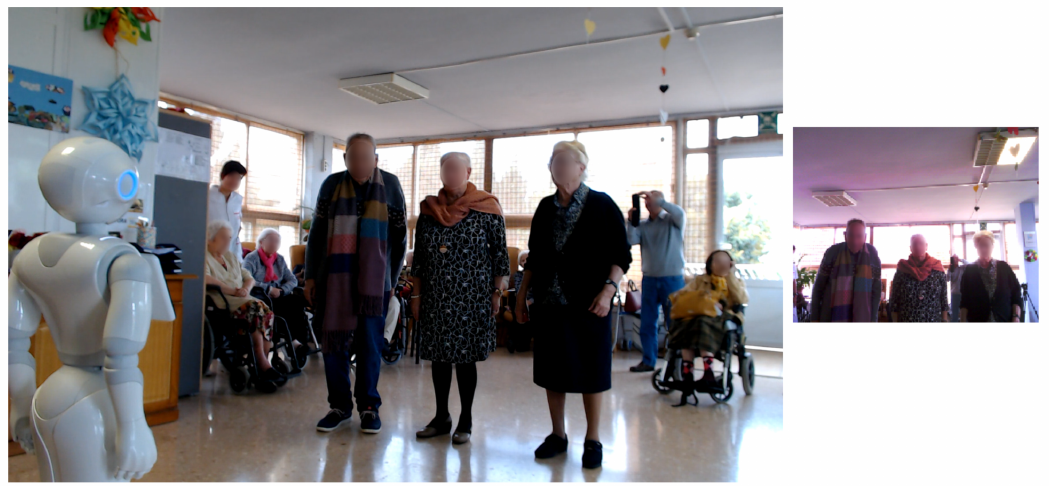
Figure 2. PHAROS robotic system in a pilot study in a care home [30].